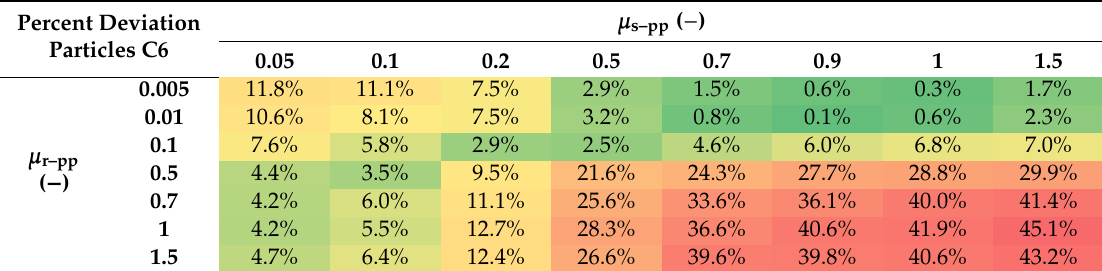
Table 5. The first estimation of frictional parameters via packing test for C6 particles.